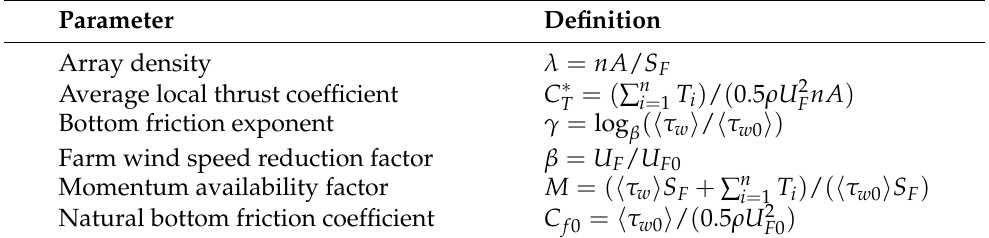
Table 1. Summary of the non-dimensional parameters used in the original farm momentum Equation (1); see [6] for further details.